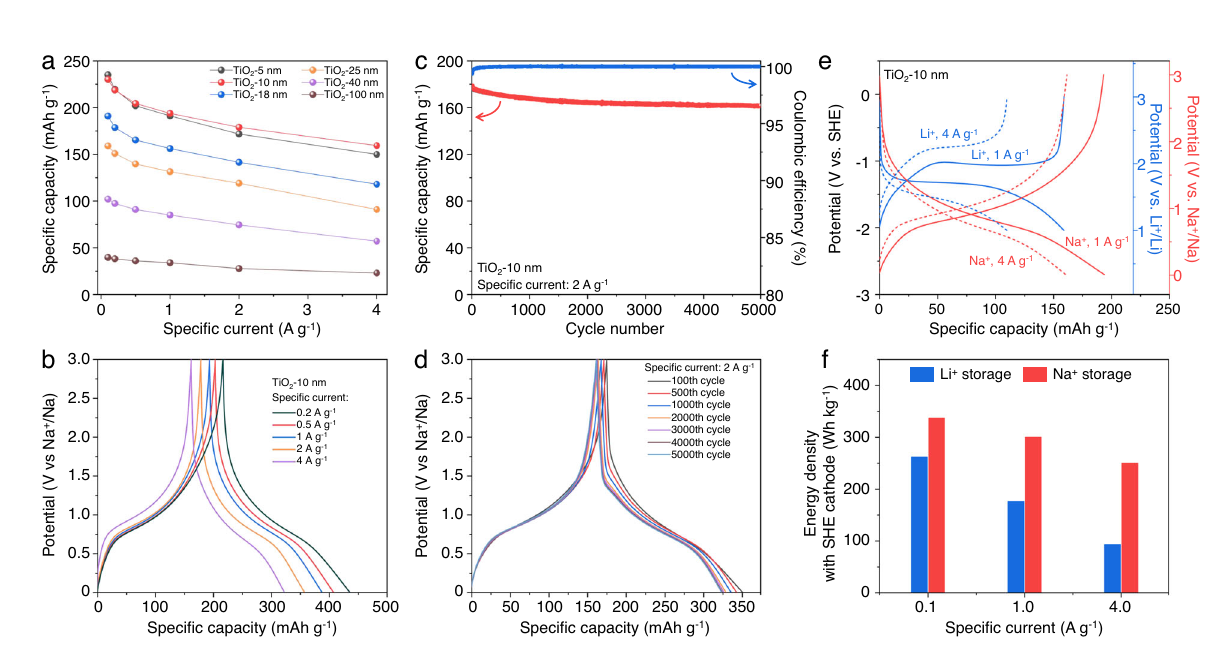
Fig. 5 | Sodium-ion storage properties of TiO 2 NPs. a Rate capability of the dif- ferent TiO 2 NPs. b Charge-discharge curves of the TiO 2 -10nm at different speci fi c currents, from 0.2 to 4Ag − 1 . Extended cycling ( c ) and related charge-discharge curvesatvariouscycles( d )fortheTiO 2 -10nmat2Ag − 1 .Excellentstabilityfor5000 cyclesisshown. e ThechargeanddischargecurvesoftheTiO 2 -10nmforLi + andNa +